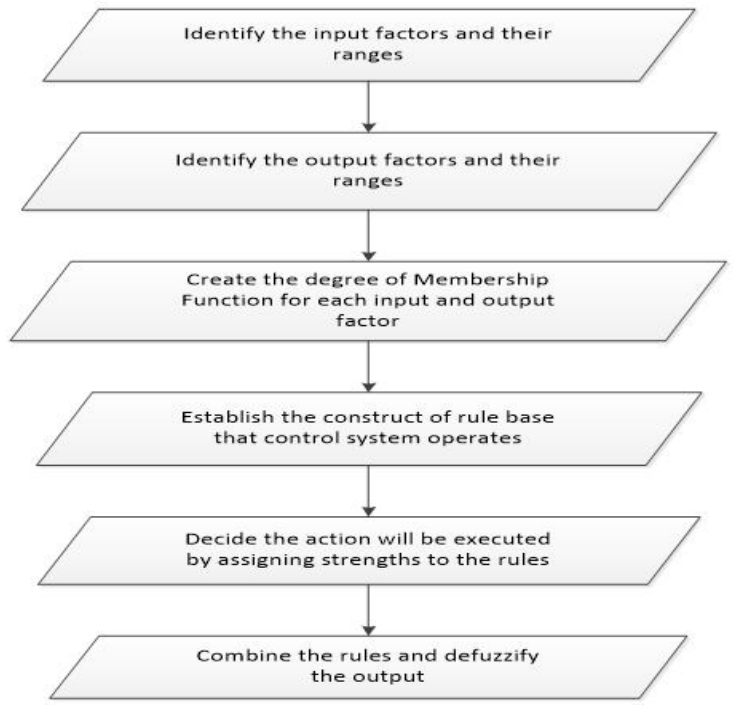
Figure 2. The steps to create fuzzy control system.